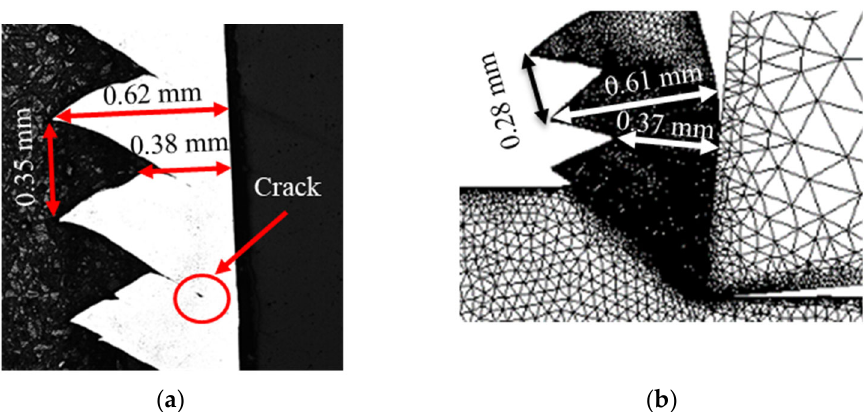
Figure 14. Experimental ( a ) and simulated ( b ) chip morphology. Cutting conditions: V c = 7.5 m/min and f = 0.4 mm (Numerical and experimental results given at the same scale).